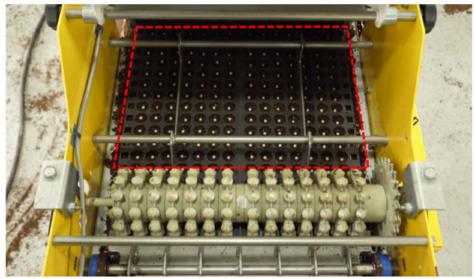
Figure 16. Measurement of the seeding rate by the seeding